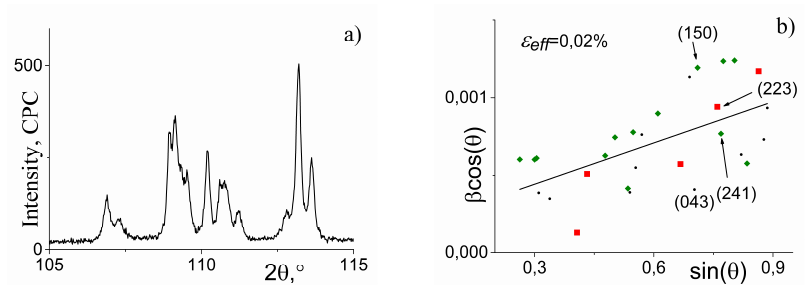
Fig. 7. Material after uniaxial deformation at 20% and annealing at 850  С. a) X-ray pattern region. Characteristic copper radiation. Diffraction peaks are very narrow. b) Williamson-Hall plot. Typical mutual arrangement of points is